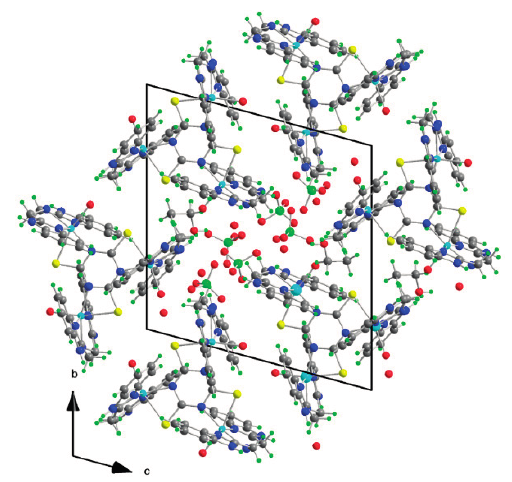
Figure 3. Projection of the contents of the unit cell along a-axis for 1 .